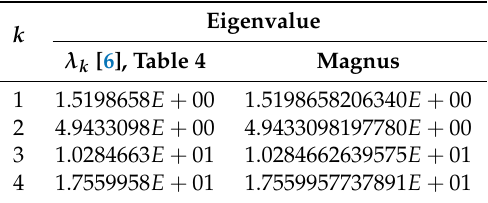
Table 1. First four eigenvalues of − y (cid:48)(cid:48) + ( x + 0.1 ) − 2 y = λ y , 0 < x < π , y ( 0 ) = y ( π ) = 0. k